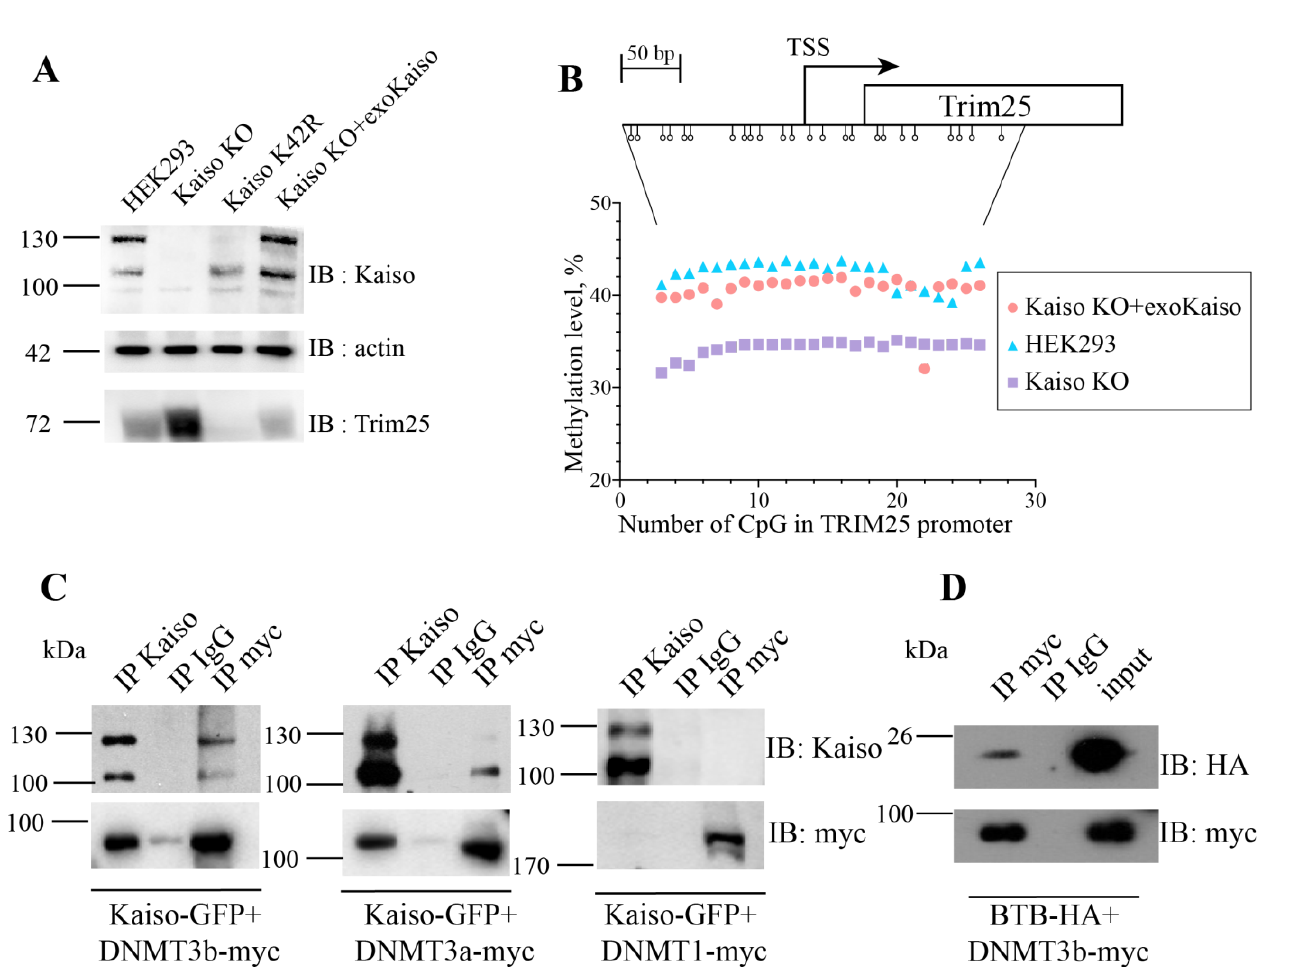
Figure 4. Kaiso regulates TRIM25 promoter methylation. ( A ) Western blot analyses of cell lysates from HEK293 cells, Kaiso deficient (Kaiso KO) and K42R mutant cells for expression of TRIM25. ( B ) Analysis of promoter TRIM25 methylation by bisulfite conversion followed by NGS sequencing. Open circles mean CpG dinucleotides. ( C ) Kaiso-GFP was cotransfected with DNMT1-myc, DNMT3a-myc, or DNMT3b-myc Western blot analysis after co-immunoprecipitation. ( D ) BTB-HA was cotransfected with DNMT3b-myc. Western blot analysis of